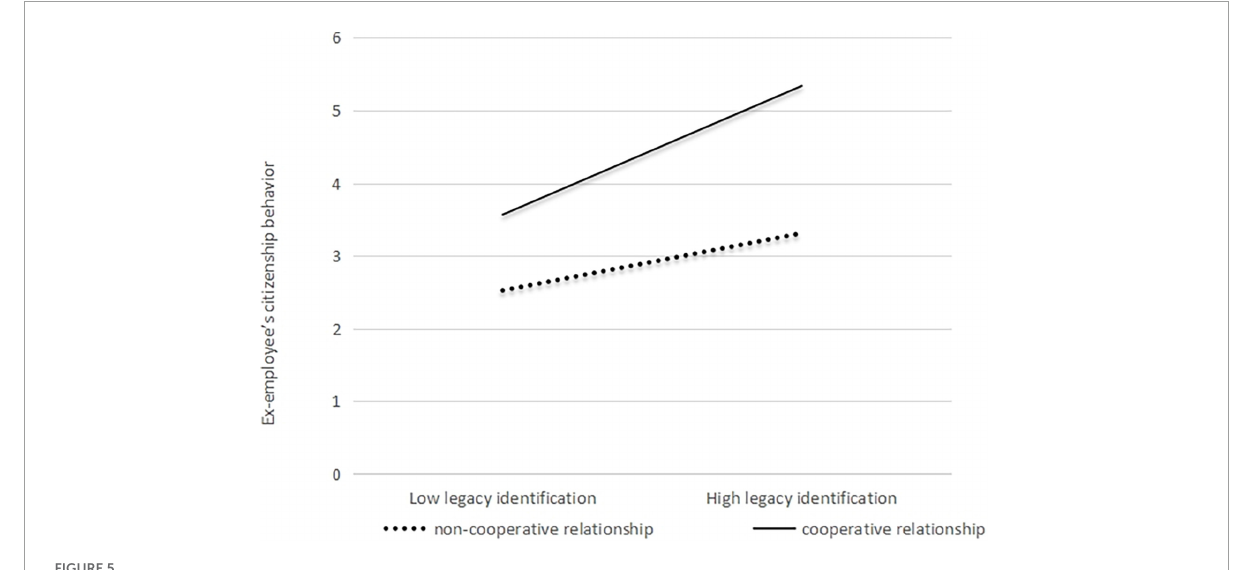
FIGURE5 Moderating effect of CR on the relationship between LI and Ex-ECB.